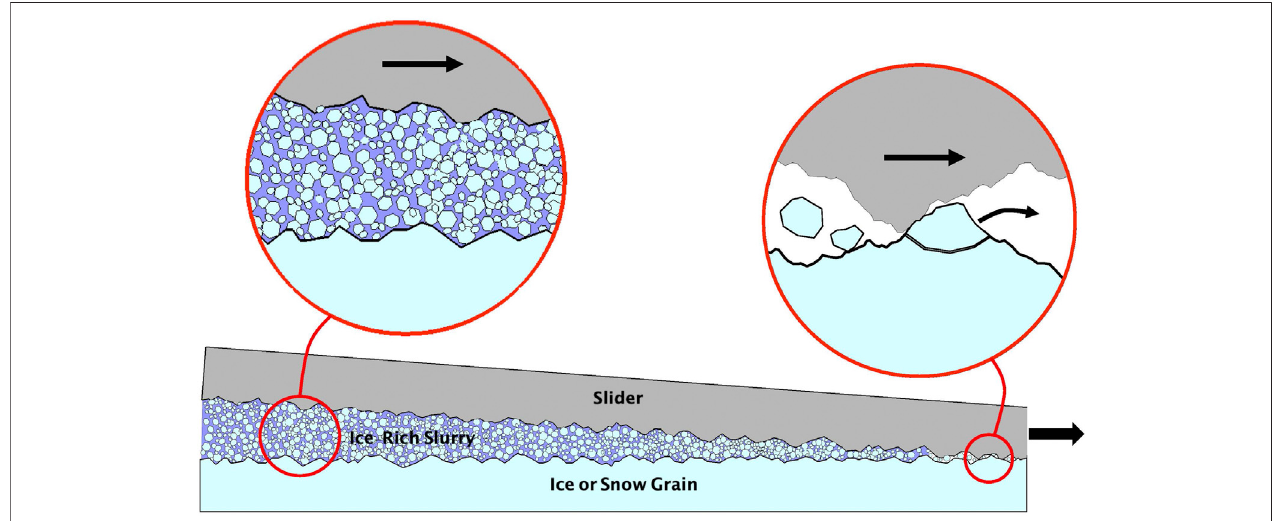
FIGURE 7 | Schematic of ice-rich slurry as a friction hypothesis. Crushing or abrasion by the slider produces ice fragments, which partially melt under contact pressure and shear motion to generate a viscoelastic, ice-rich slurry that separates and lubricates the two surfaces.